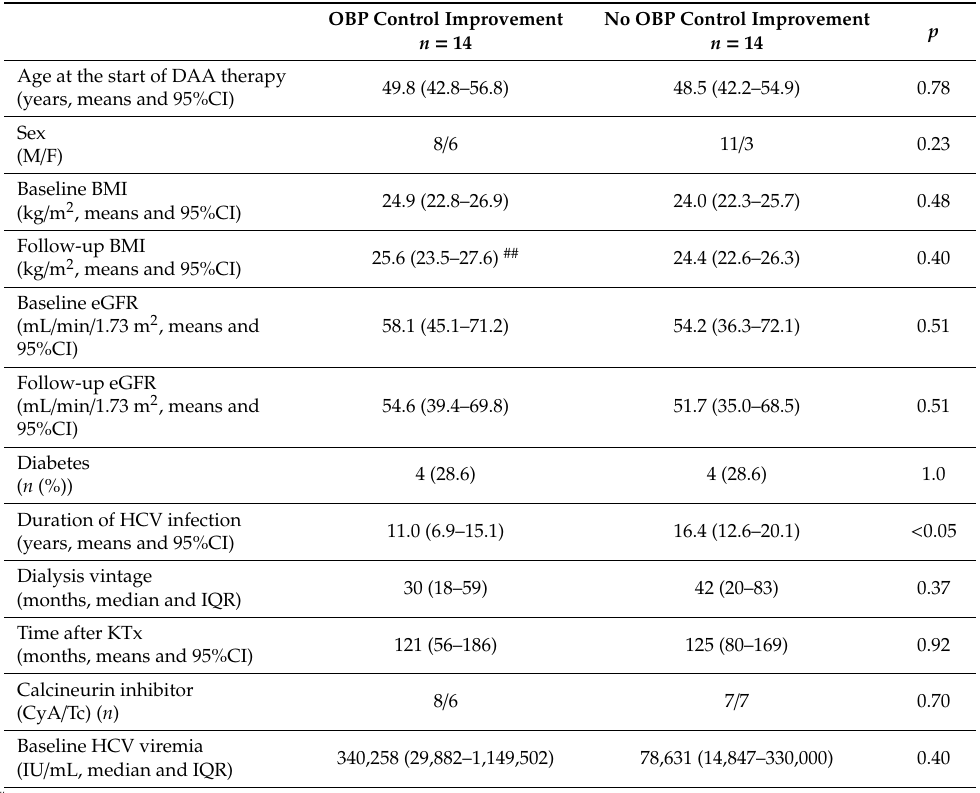
Figure 1. Study flow chart. KTRs, kidney transplant recipients; HCV, hepatitis C virus; PCR, polymerase chain reaction. Table 1. Characteristics of direct antiviral agents-treated kidney transplant recipients stratified to subgroups based on blood pressure control improvement in the follow-up period.